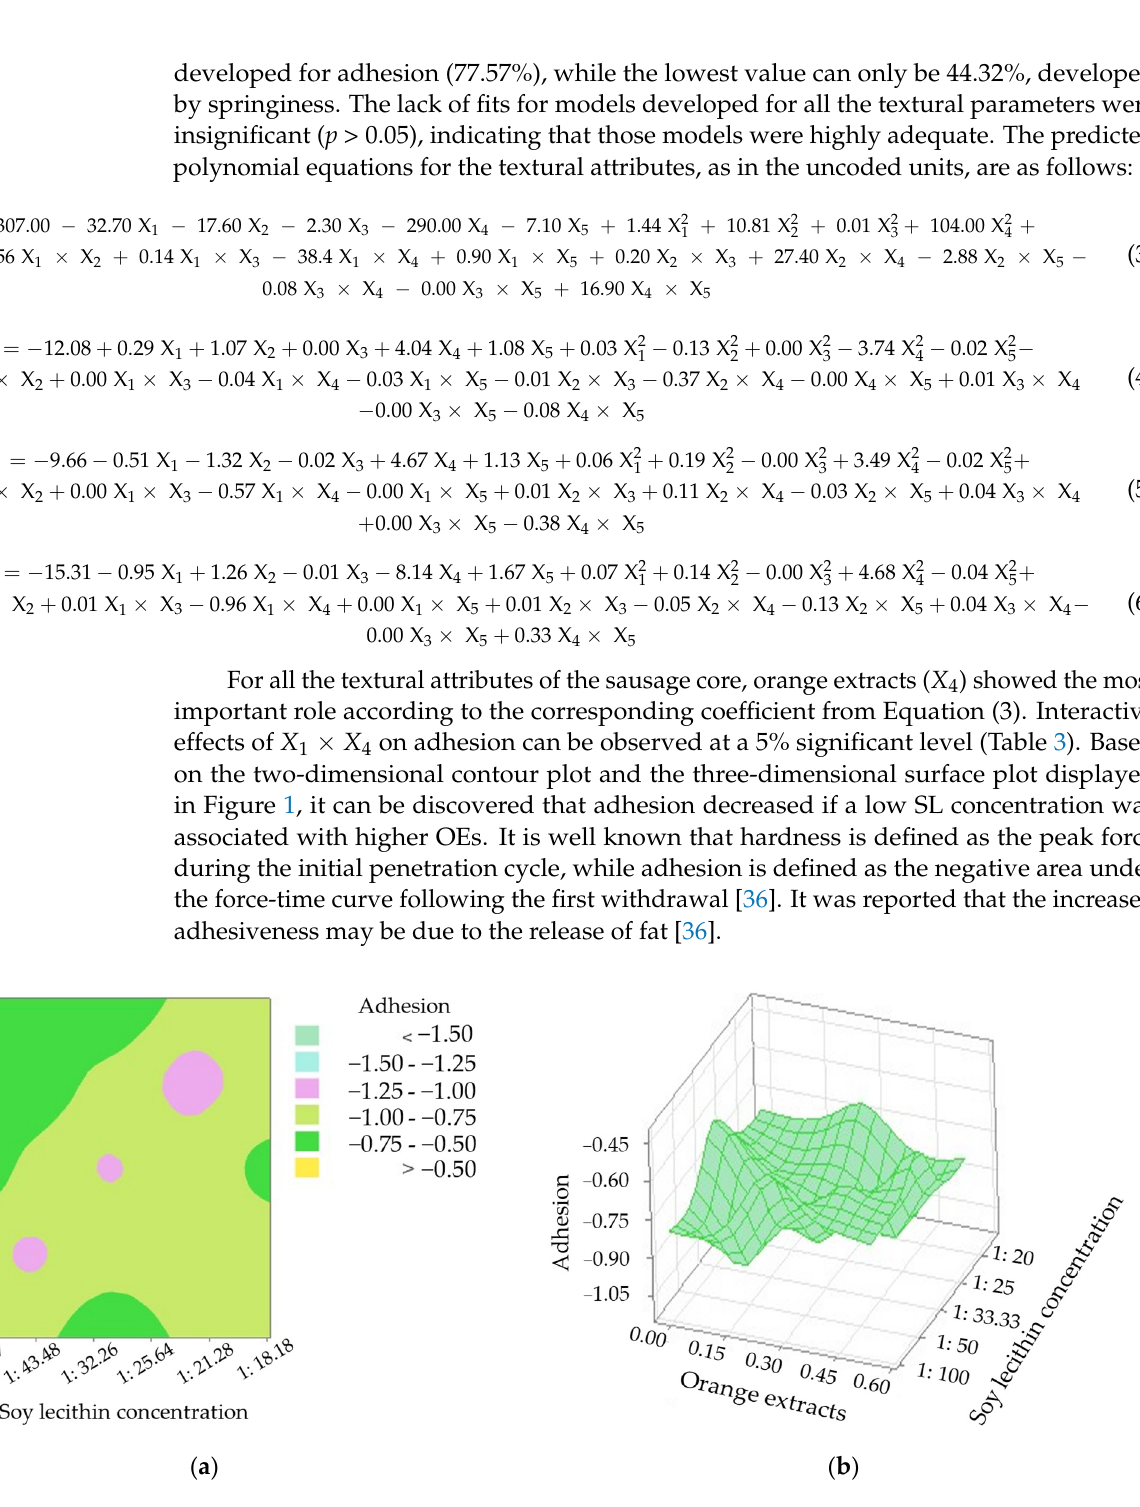
Figure 1. Adhesion of the sausage cores with modified casings as affected by orange extracts additions and concentration of soy lecithin. ( a ) two-dimensional contour plot; ( b ) three-dimensional surface